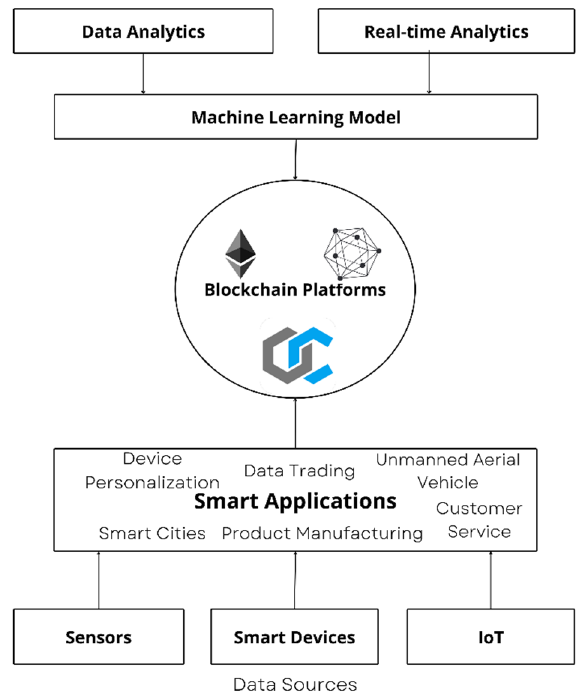
Figure 2. AI and blockchain relationship.